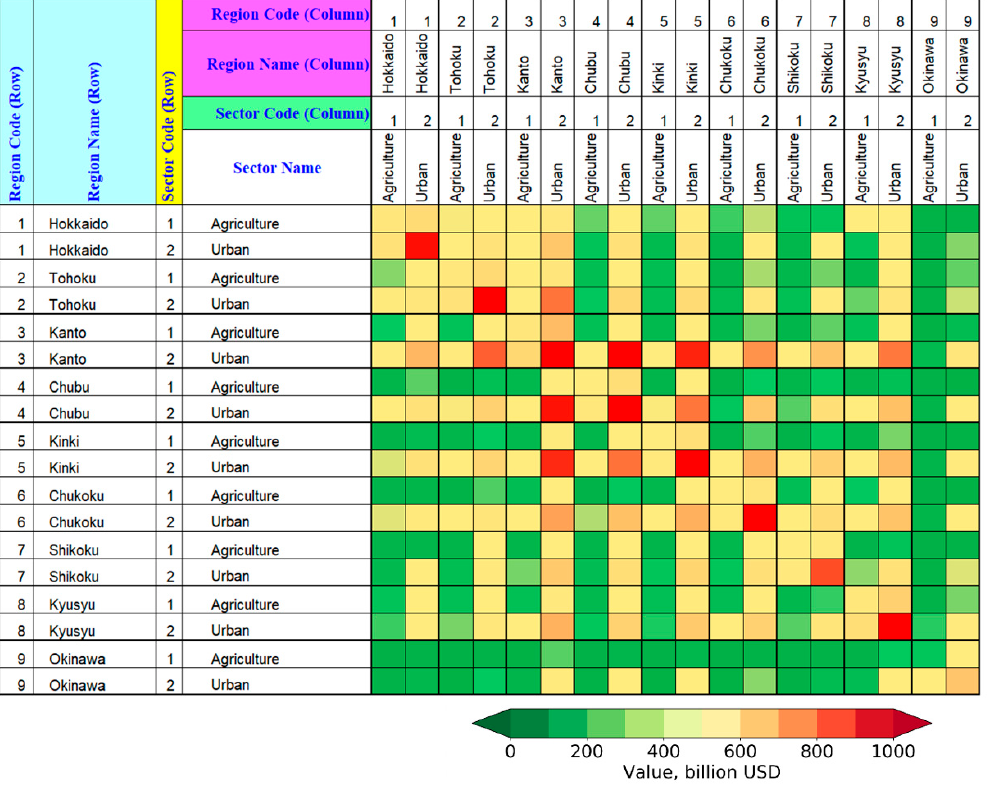
Figure 4. Economic data in Japan represented by 9 large regions. Economic network based on the 9 regions in Japan and the trade value between regions.